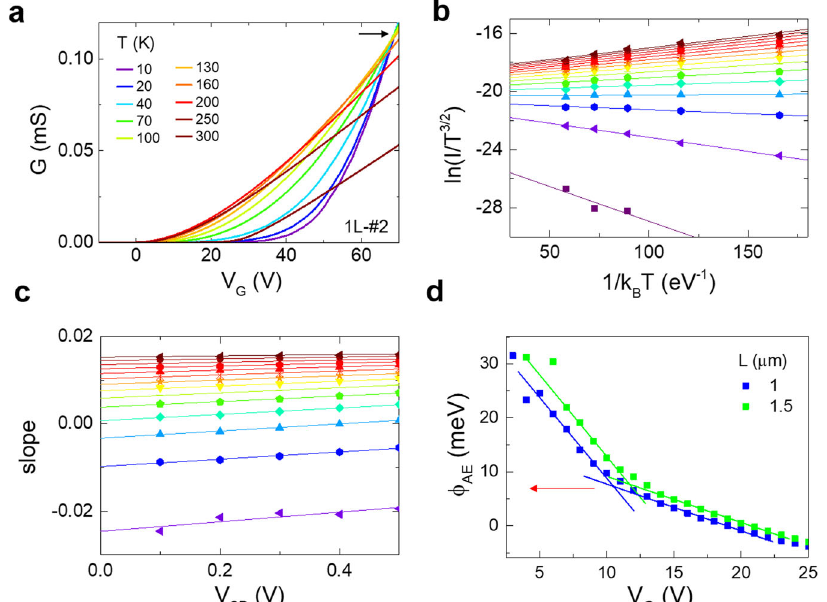
Fig. 5 Schottky barrier height at In/MoS 2 contacts. a G – V G curves at various temperatures obtained from the L = 1 μ m channel of 1L-#2 MoS 2 device, indicated by a dashed box in Supplementary Fig. 13a. b Scattered points: ln ð I = T 3 = 2 Þ as a function of 1 = k B T with V SD = 0.5 V from V G = 0 V to 70 V with 5 V spacing (from bottom to top) obtained from the L = 1 μ m channel. Solid lines: fi tting result to obtain slope values for each V G value. c Scattered points: slope as a function of V SD for various V G (5 V to 70 V with 5 V spacing from bottom to top). Solid lines: fi tting result to obtain ϕ AE at V SD = 0 V for each V G value. d ϕ AE as a function of V G for L = 1 and 1.5 μ m channels. The arrow indicates the ϕ SB (~7 meV) for the 1L-#2 MoS 2